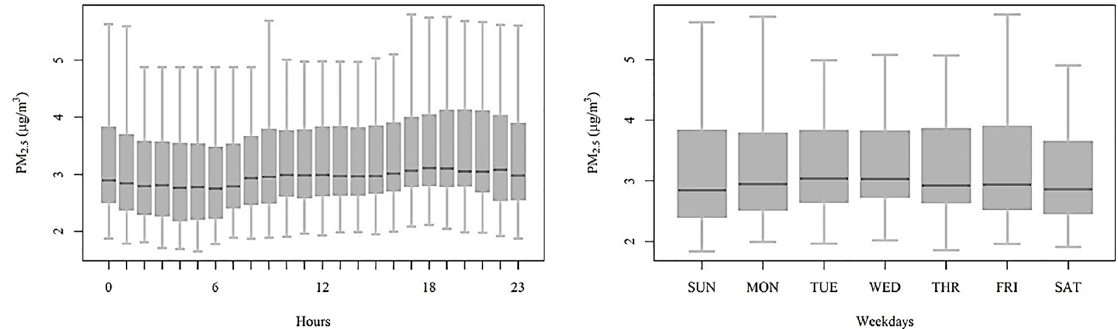
Figure 7. The mean daily and weekday patterns of the PM concentrations measured over the two periods.